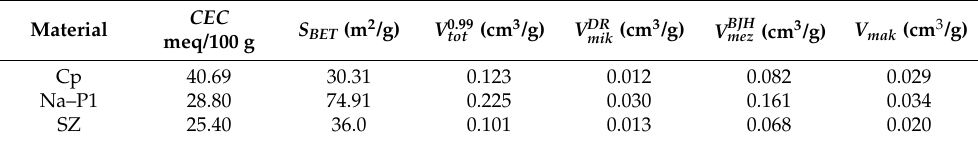
Table 4. Summary of the textural parameters. Symbols: Cp—clinoptilolite (reference material); Na–